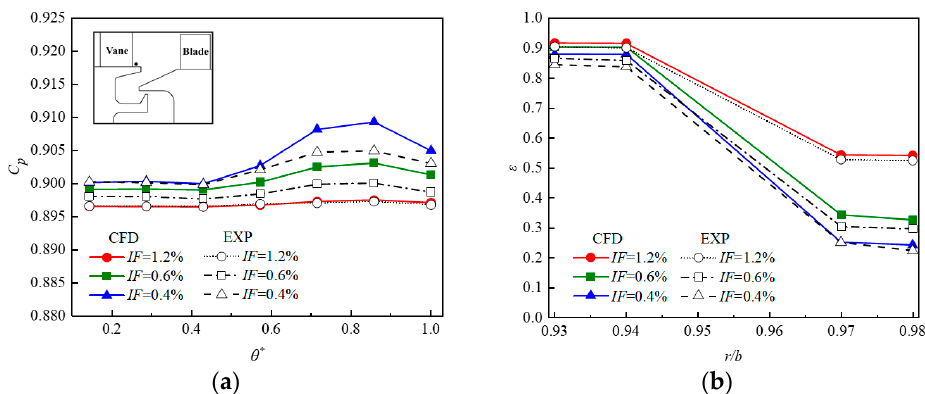
Figure 7. Comparison of the results of numerical simulation and experimental results. ( a ) Circumferential pressure distribution downstream of the vane. ( b ) Sealing efficiency distribution along the disk cavity radial direction.